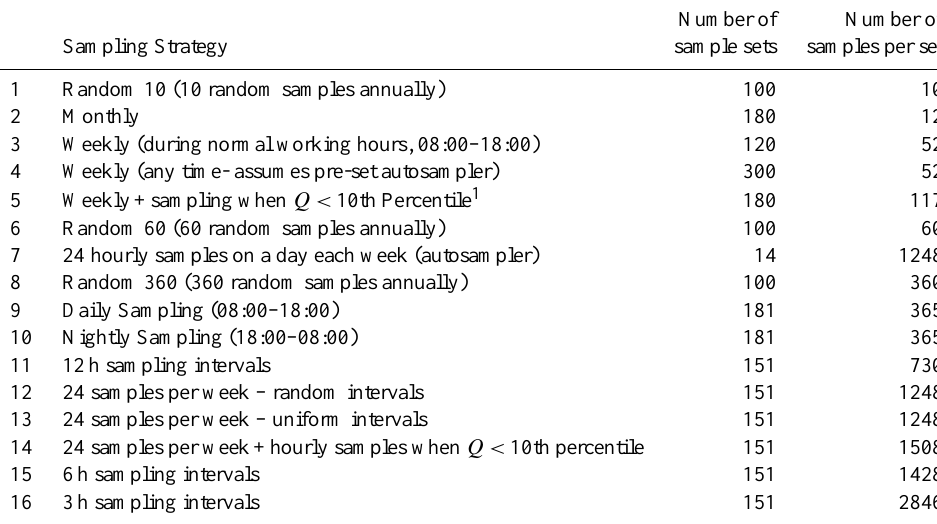
Table 1. Series of sampling solutions used to estimate TP load based on the PARCOM algorithm (Eq. 1) showing the number of sample sets and samples per set used in each